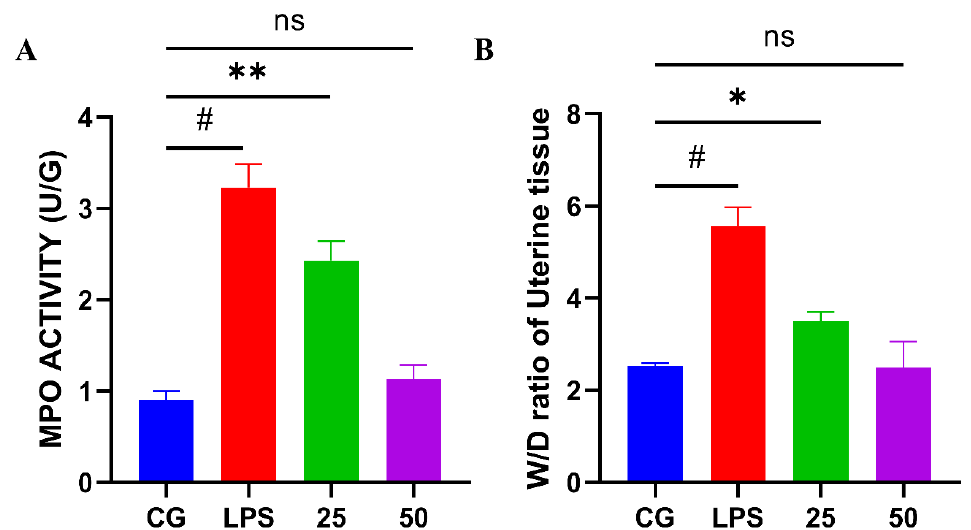
Figure 3. Consequence of GnRb1 against MPO activity assay and W/D ratio in mice uterus. ( A ) MPO (U/G) activity. ( B ) W/D ratio. CG represents the control group. LPS reveals the LPS-induced groups. The 25 and 50 are the GnRb1-administrated groups representing 25 mg/kg and 50 mg/kg per animal, respectively. GnRb1 indicates the Ginsenoside Rb1. MPO indicates the myeloperoxidase, whereas W/D depicts the wet to dry weight ratio. Data statistics are demonstrated as mean ± S.E.M. The # p < 0.001 CG versus LPS group, * p < 0.05, ** p < 0.01, and ns indicates the nonsignificant difference between CG versus LPS + GnRb1 groups.